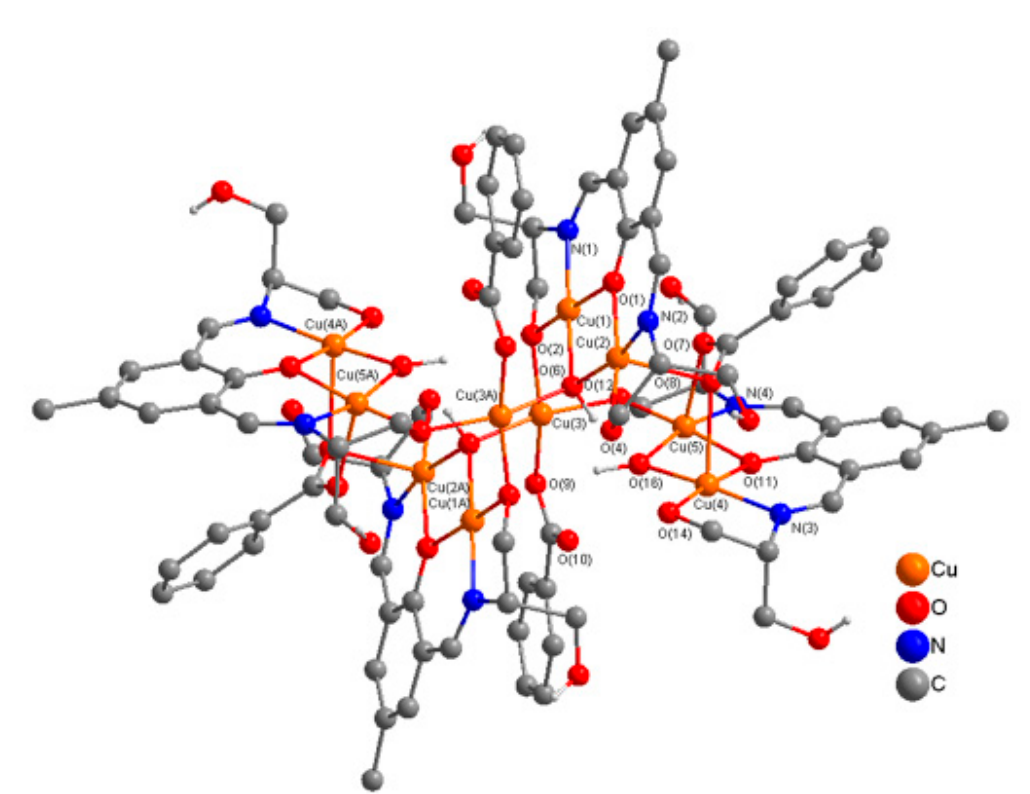
Figure 10. Perspective view of a cationic unit [Cu 10 (H 3 L1 2 − ) 4 (O) 2 (OH) 2 (C 6 H 5 CO 2 ) 4 ] 2 + in decanuclear complex 6 with relevant numbering. H-atoms, solvent molecules and uncoordinated [C 6 H 5 CO 2 − ] 2 anions are omitted for clarity.